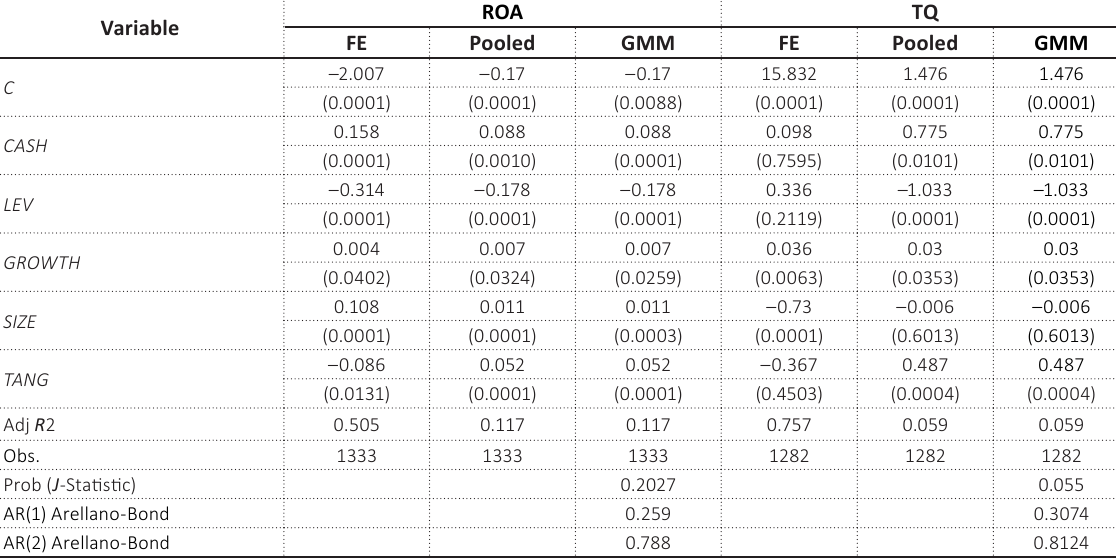
Table 2. Results of the effect of cash level on GCC firms’